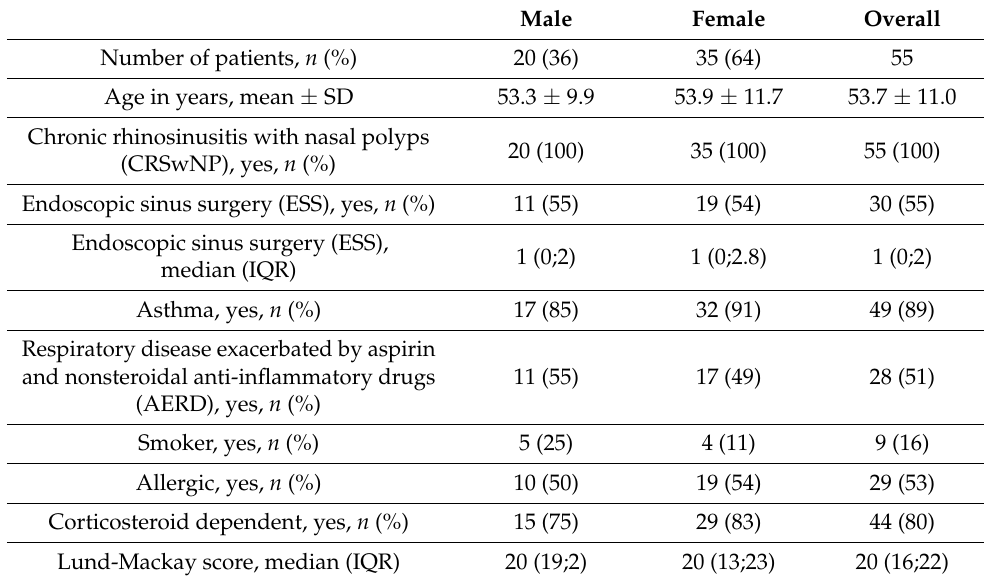
Table 1. Demographic and baseline clinical characteristics of the treated